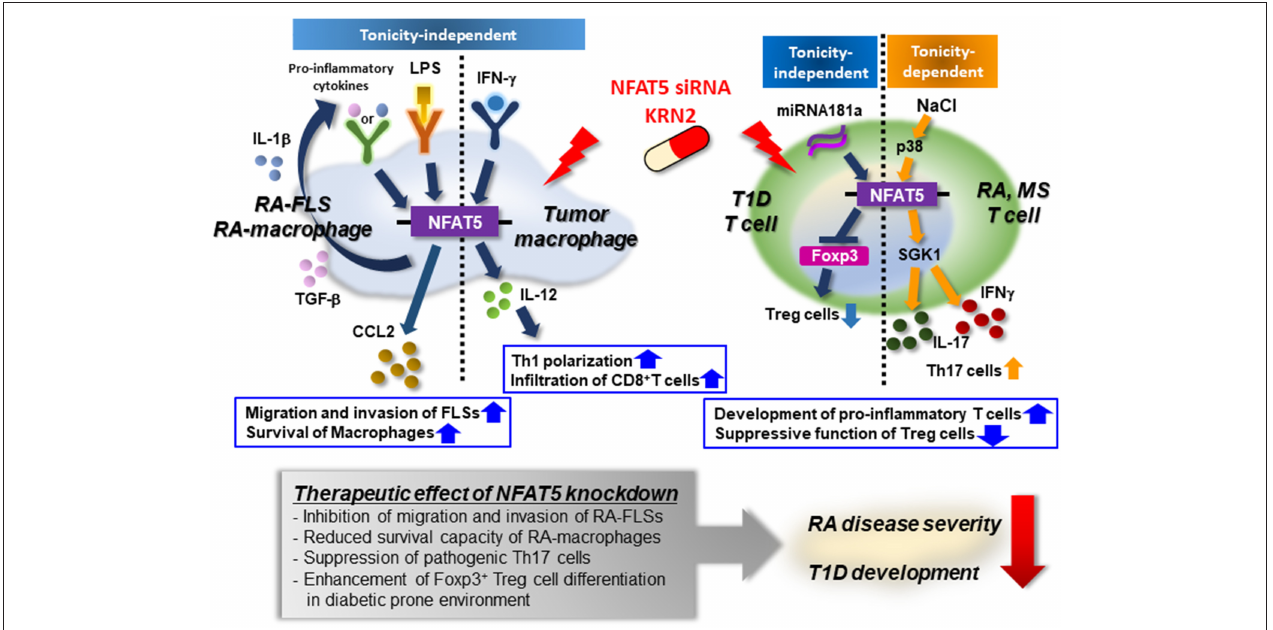
FIGURE 3 | Mode of action of NFAT5 as a therapeutic target for autoimmune diseases. Pro-inflammatory cytokines (e.g., IL-1 β and TGF- β ) or TLR ligand (e.g., LPS) enhances the expression of NFAT5 in rheumatoid arthritis (RA)-FLSs and RA macrophages. Up-regulated NFAT5, in turn, produces CCL2, promoting RA-FLS migration and invasion and conferring on RA-macrophages apoptotic resistance. IFN- γ promotes NFAT5-dependent IL-12 production, which mediates T H 1 polarization, and the infiltration of CD8 + T cells into tumor microenvironments. High salt also increases the expression of NFAT5 via the p38-mediated pathway, resulting in the development of pro-inflammatory T cells that produce IL-17 and/or IFN γ . Furthermore, in diabetes-prone mice, NFAT5 suppresses the differentiation of Foxp3 + Treg cells, breaking peripheral tolerance. As a therapeutic target, NFAT5 siRNA or KRN2 prevents the pathologic action of NFAT5 and alleviates the progression of RA and T1D. Therefore, NFAT5 blockades may be considered a promising strategy to treat autoimmune diseases, including RA and